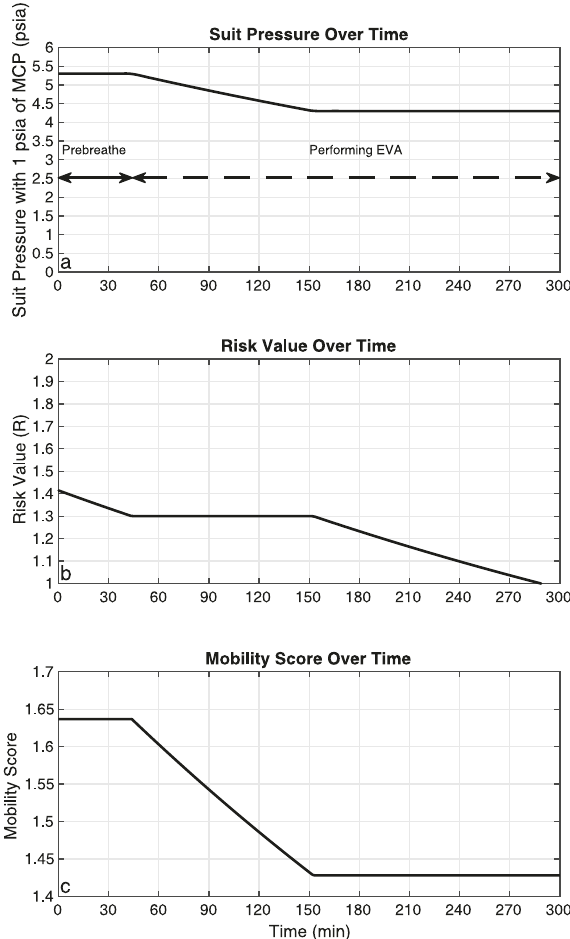
Fig. 5 Framework quantifying the physiological and operational bene fi ts of variable pressure spacesuits in the context of the SmartSuit spacesuit architecture, which includes an initial space- suit pressure of 5.3 psia (4.3 psia of gas pressure and 1 psia of MCP), and a DCS risk value before EVA of R = 1.3 in a habitat with an Adjusted Space Shuttle atmospheric condition. Prebreathe activities are necessary for 40 min to attain a DCS risk value of R = 1.3. Then, the EVA begins while the gas pressure of the spacesuit is steadily decreased as astronauts continue to breath pure oxygen within the spacesuit (while maintaining a DCS risk of R = 1.3). After the 150-min mark, the spacesuit total pressure of 4.3 psia (3.3 psia of gas pressure plus 1 psia of MCP) is sustained for the rest of the EVA. The reduction of gas pressure from 4.3 psia to 3.3 psia improves the mobility score from ~1.65 to just under 1.45. Just before the 300-min mark, the risk value moves below 1, indicating that there is no more risk of